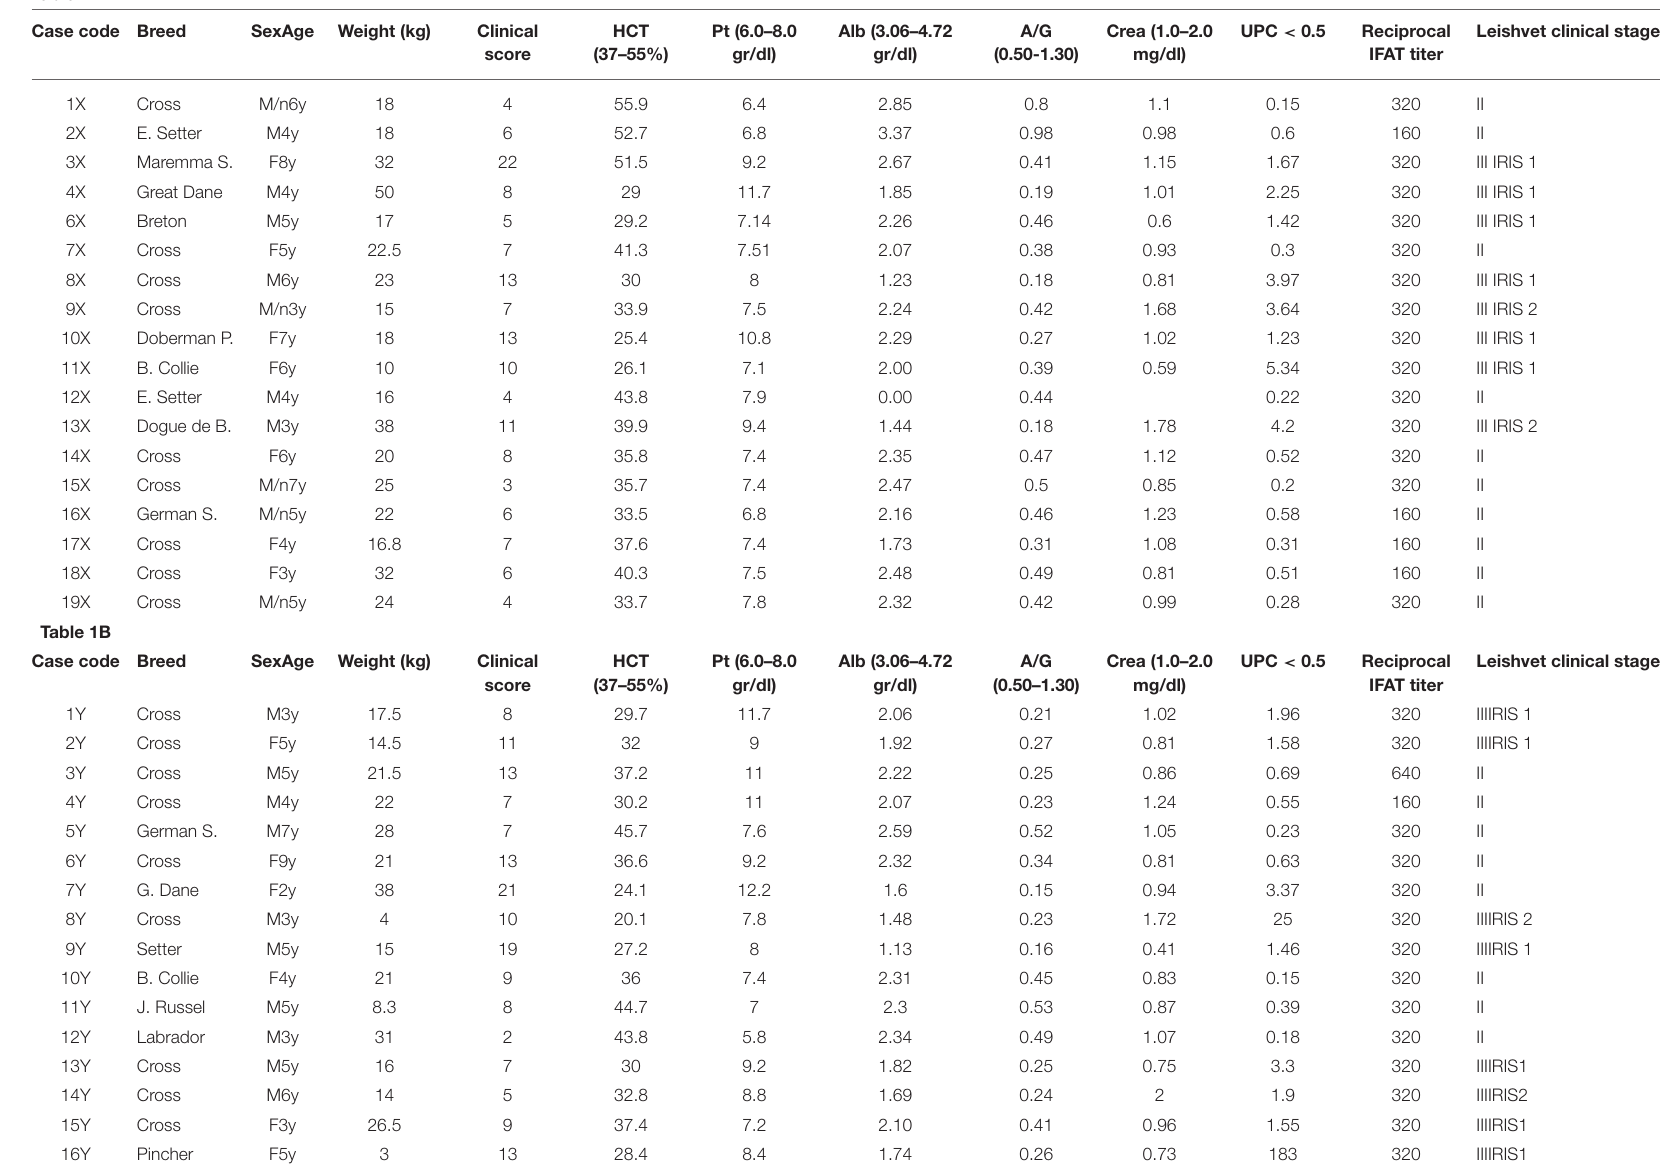
Dogs were clinically classified according to Leishvet and IRIS